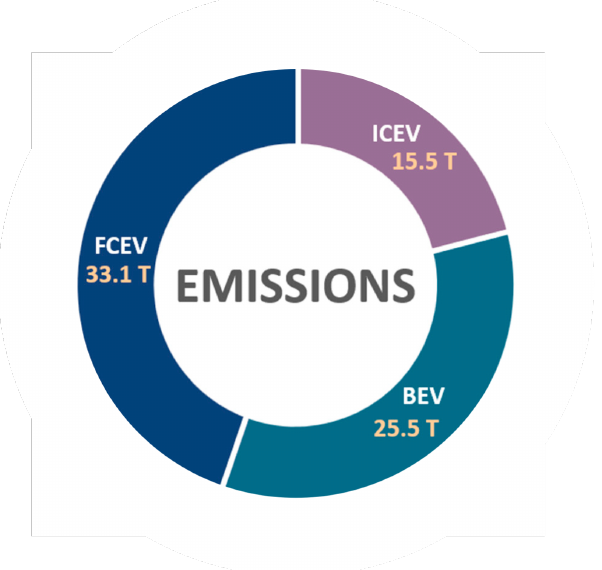
Figure 2. The emissions from the production of fuel and vehicles for battery electric vehicles, fuel cell electric vehicles, and internal combustion vehicles